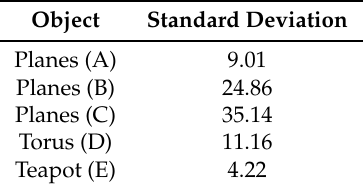
Table 2. SD values for depths around the eliminated areas in Figure